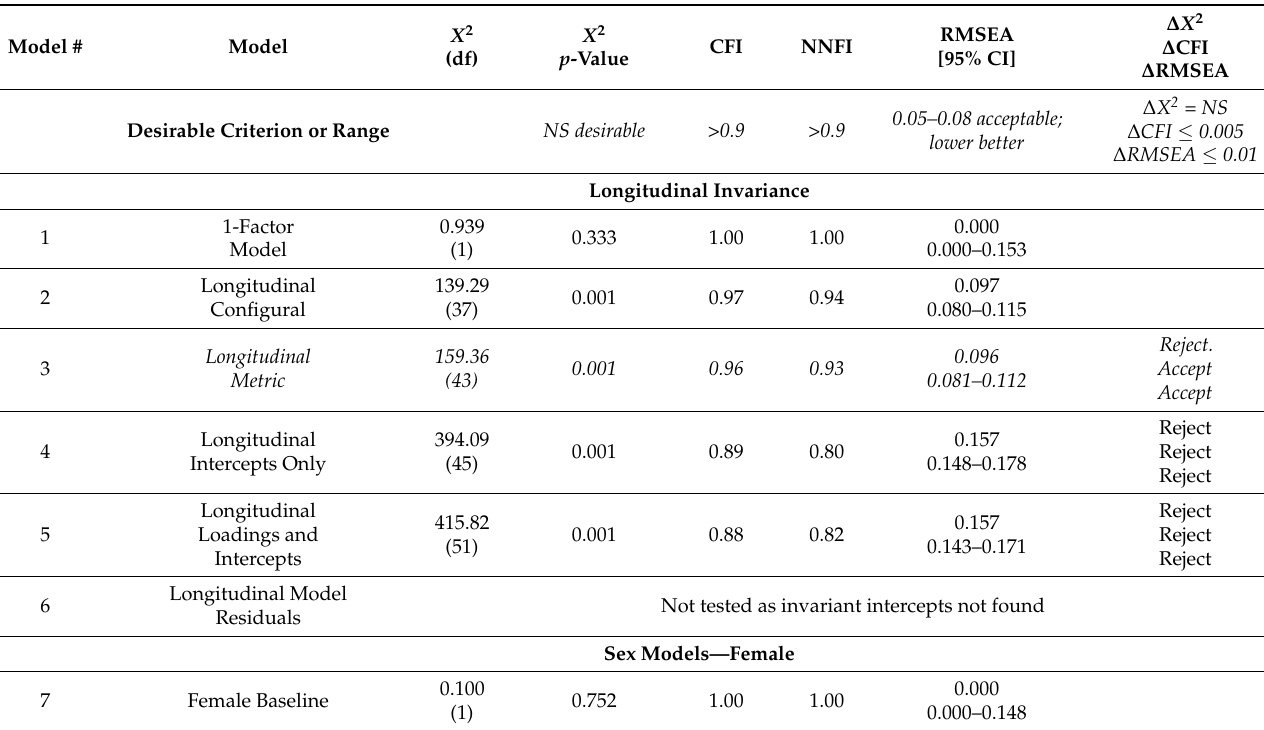
Figure 2. Baseline confirmatory factor analysis model. FitnessBl = latent factor; Speed = treadmill speed; VO 2 max = age-sex percentile of VO 2 max; Curls = Curl-ups; Pus = Push-ups; e# = error terms. Squares are measured variables; circles are latent variables. Table 1. Model Comparison for Physical Activity/Fitness Models.